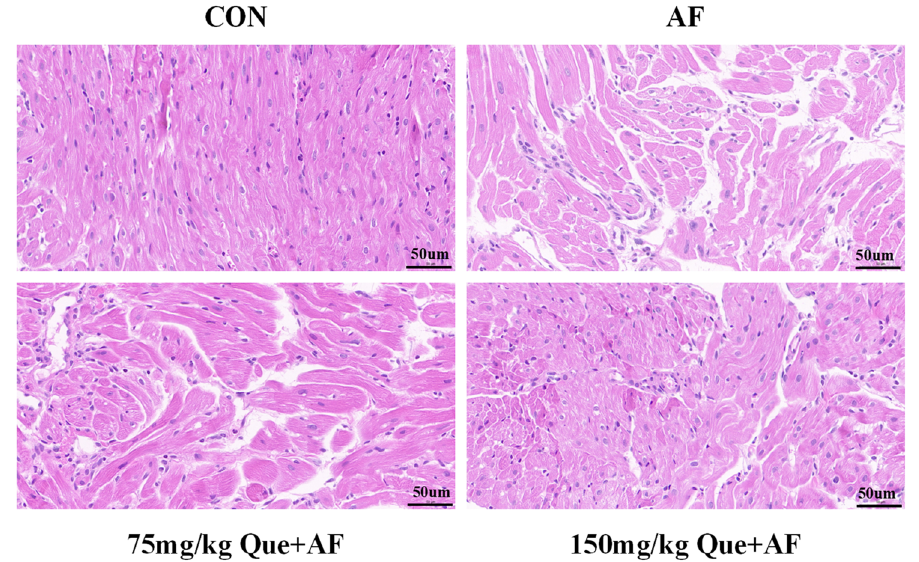
Figure 10. Morphological and structural changes of atrial myocytes in each group of